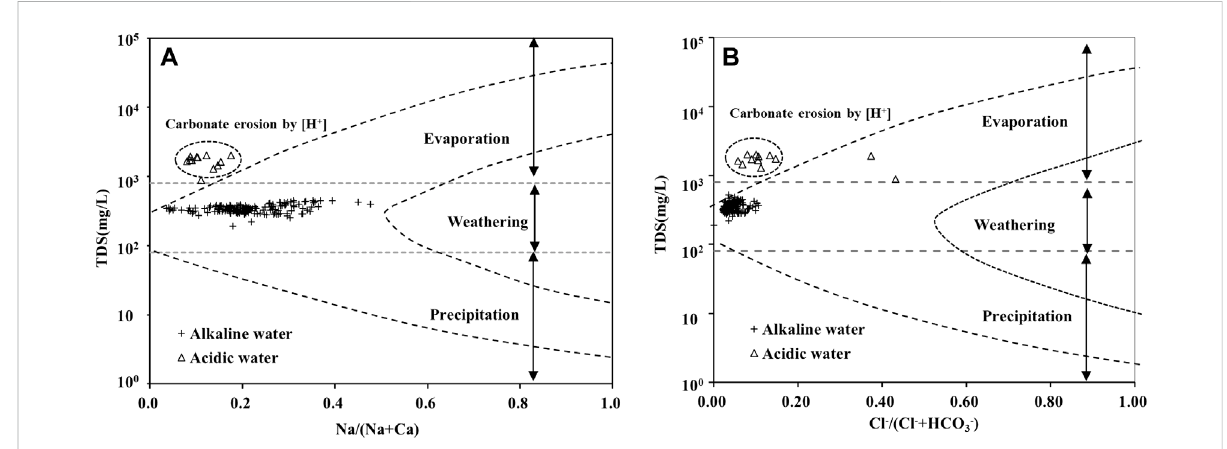
FIGURE 8 Gibbs diagram of the Huatan River based on the relationship of (A) TDS versus Na + /(Na + +Ca 2+ ); (B) TDS versus Cl − /(Cl − +HCO 3 − ).